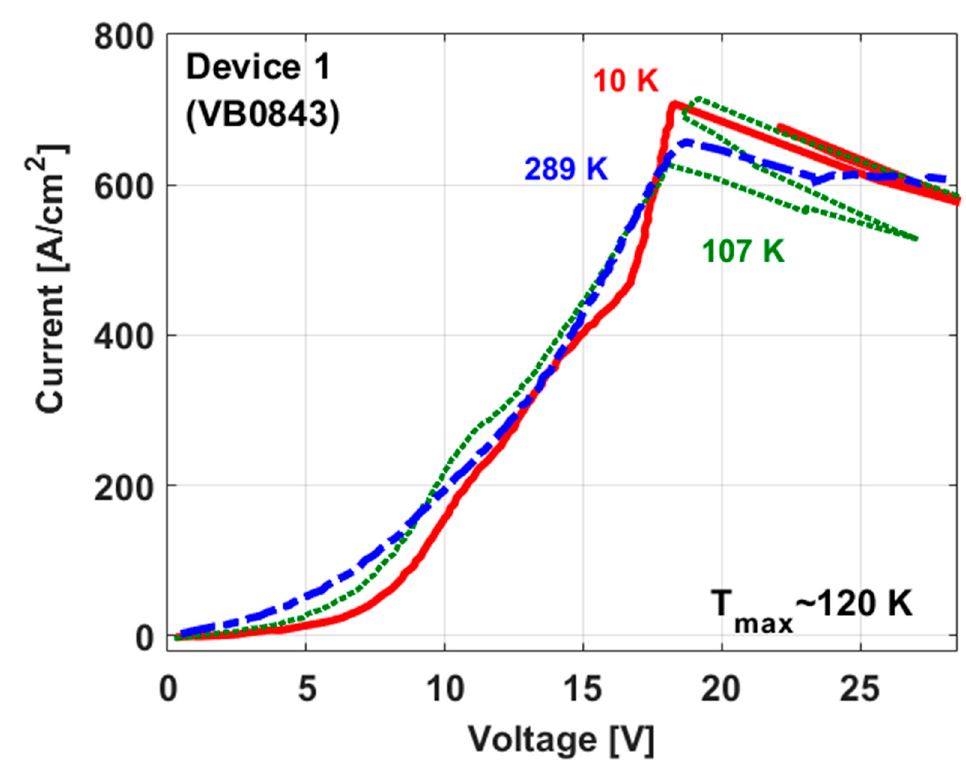
Figure 3. Current curves as a function of voltage for Device 1 (wafer VB0843) at low, maximum, and room temperatures. The measured maximum operating (lasing) temperature is 120 K, as indicated.